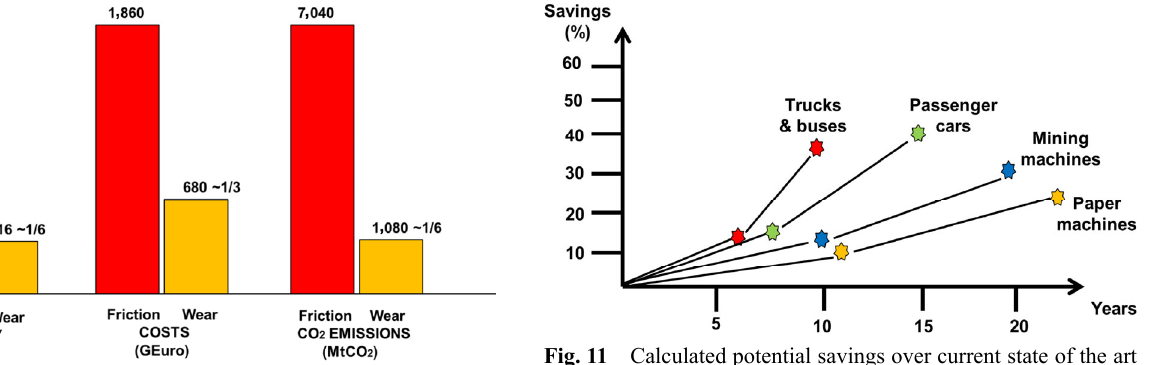
Fig. 10 Energy consumption, costs and CO 2 emissions due to friction and wear globally.